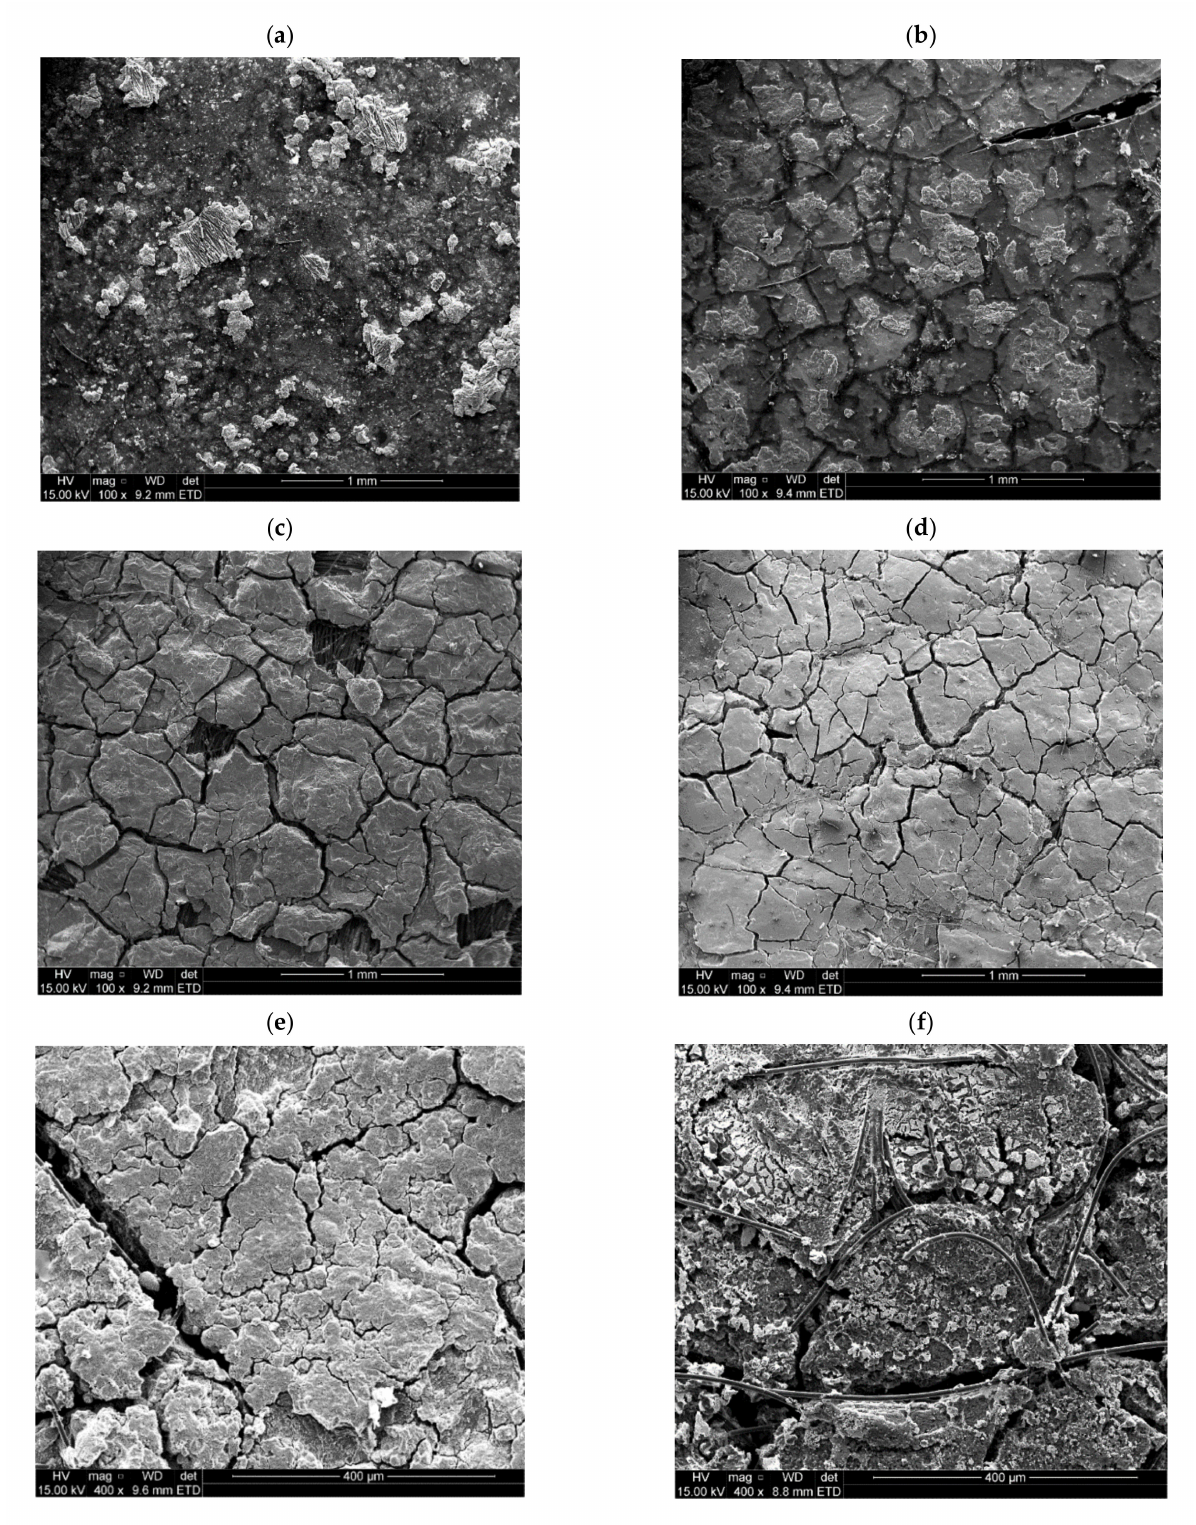
Figure 17. SEM images/surface morphologies of MEA components (before and after ammonia exposure): ( a ) membrane before ammonia exposure, ( b ) affected membrane after ammonia exposure, ( c ) cathode GDL (Pt catalyst) before ammonia exposure, ( d ) cathode GDL (Pt catalyst) after ammonia exposure, ( e ) anode GDL (Pt/Co catalyst) before ammonia exposure and ( f ) anode GDL (Pt/Co catalyst) after ammonia exposure (MEA: membrane electrode assembly; GDL: gas diffusion